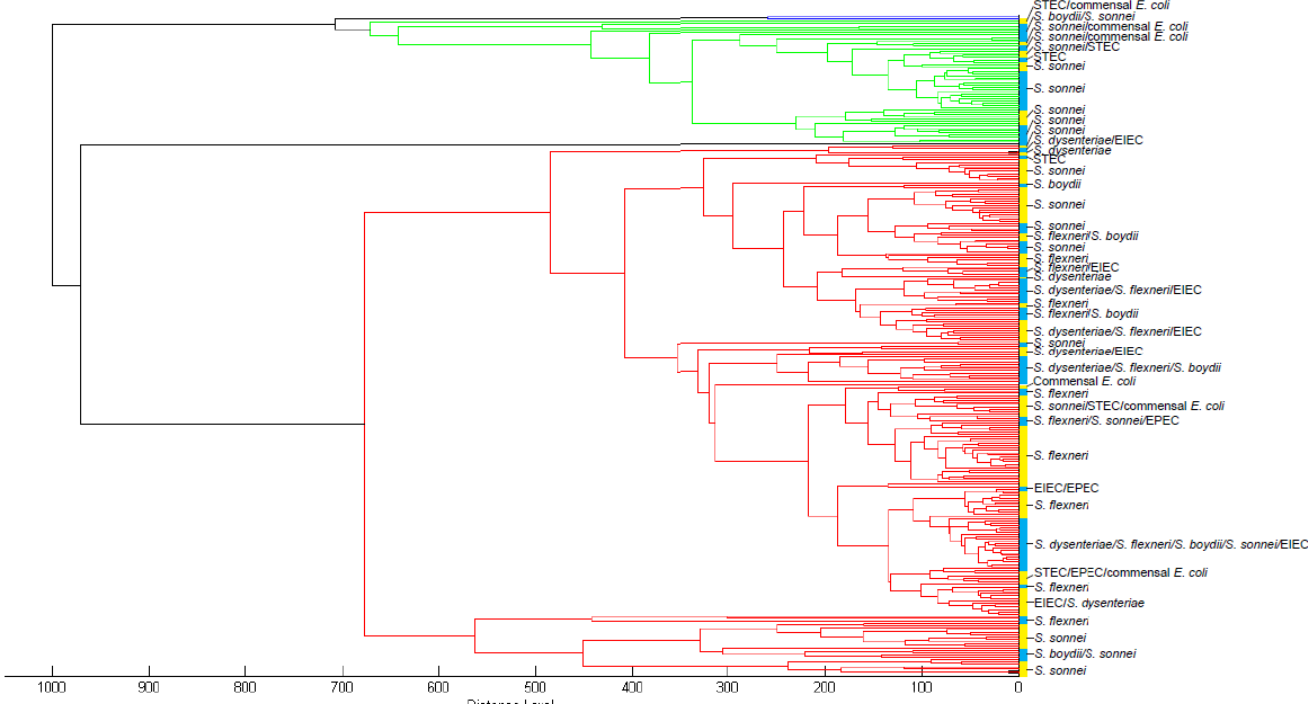
Figure 2. Dendrogram of MSPs of training isolates. Blue = cluster 1; green = cluster 2; red = cluster 3. Yellow/blue vertical band = manual cluster distinction at distance level 50–100 relative units with species designation using the culture-based identification algorithm.